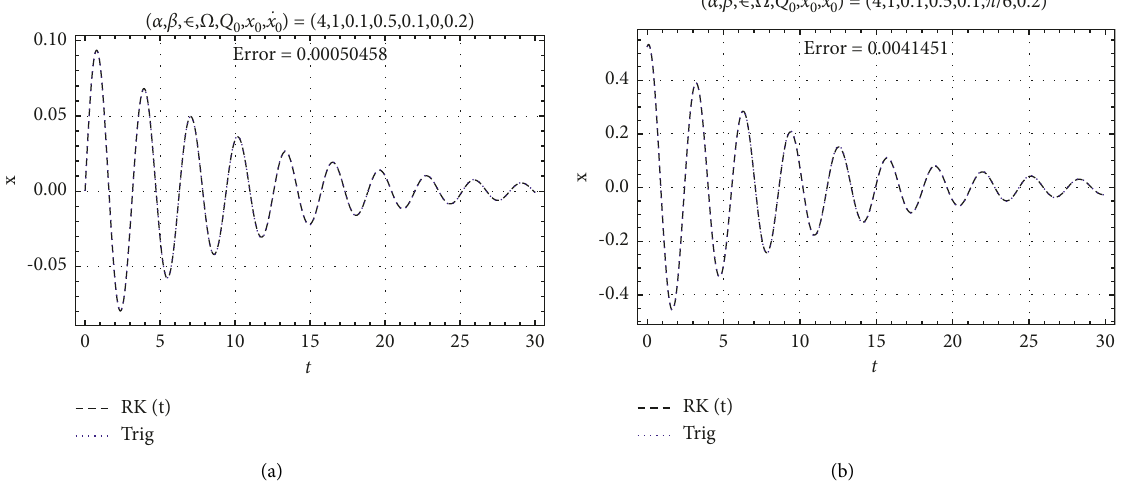
Figure 4: Both trigonometric approximation (31) and RK numerical simulation to the damped Duffing–Mathieu problem (10) are compared with each other for different values to the initial amplitude x 0 .